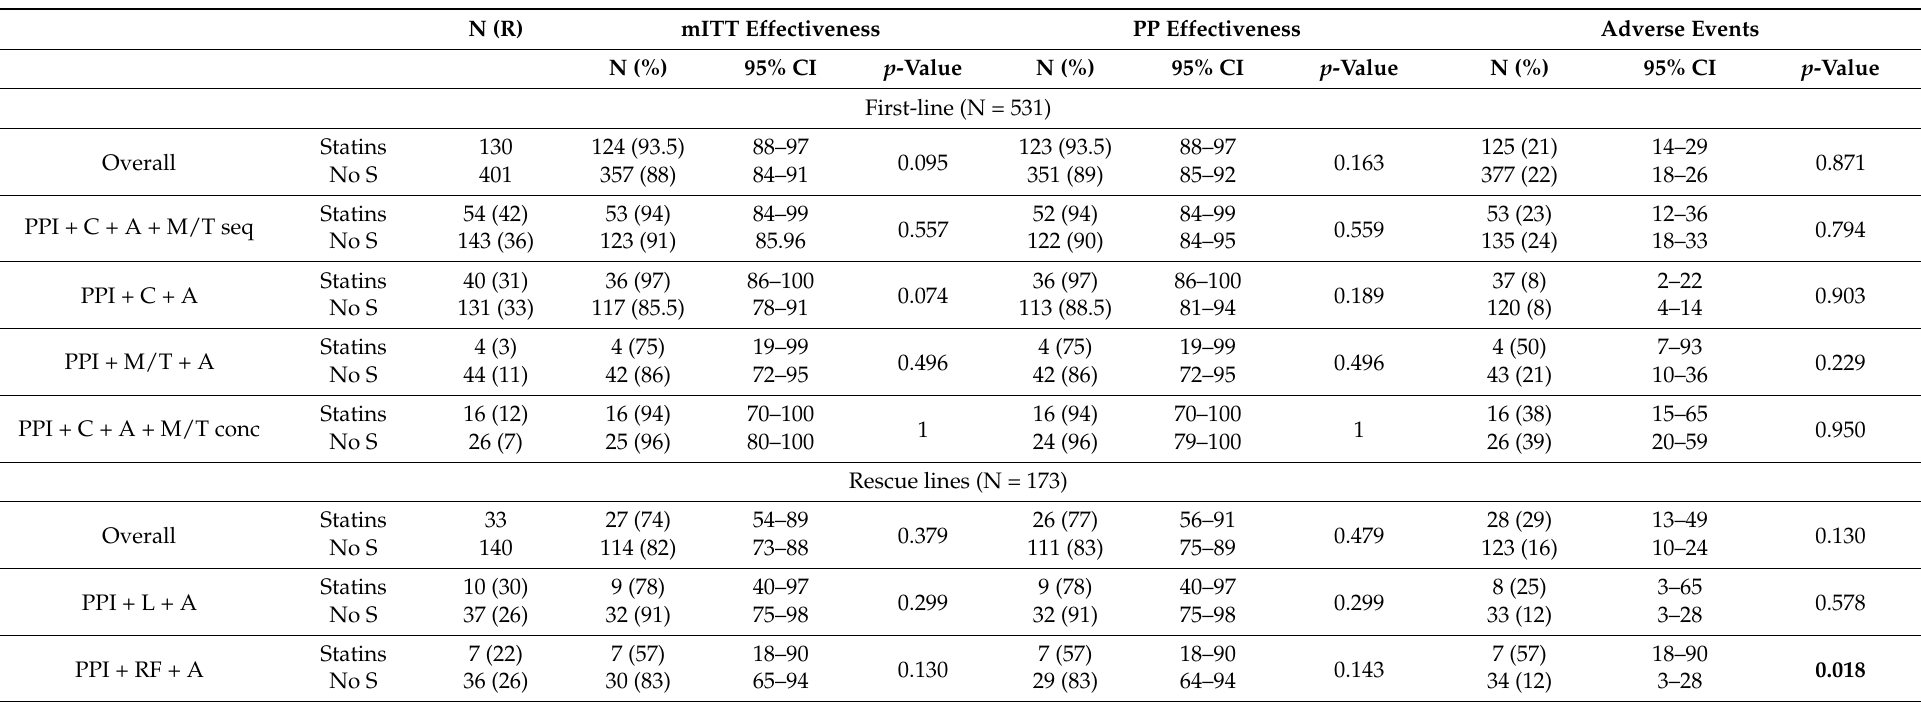
Table 9. Effectiveness and safety in culture-guided eradication